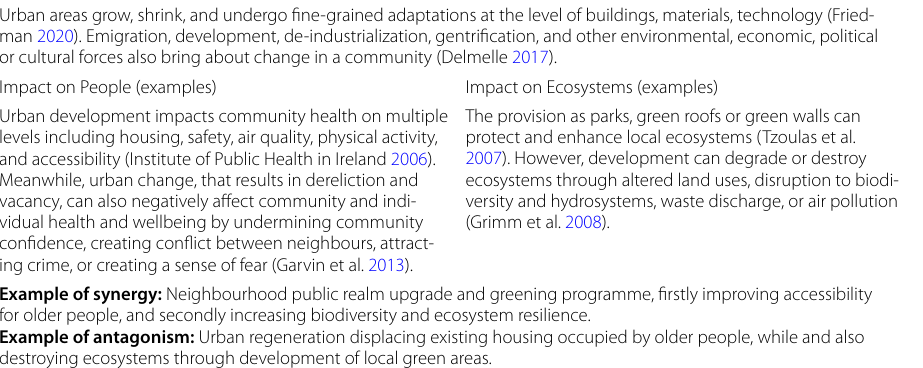
Table 2 Urban environment, growth, and